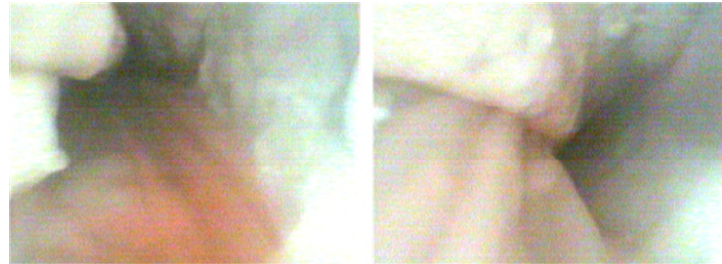
Figure 8. Randomly sampled WCE images of the pig’s gastrointestinal tract.